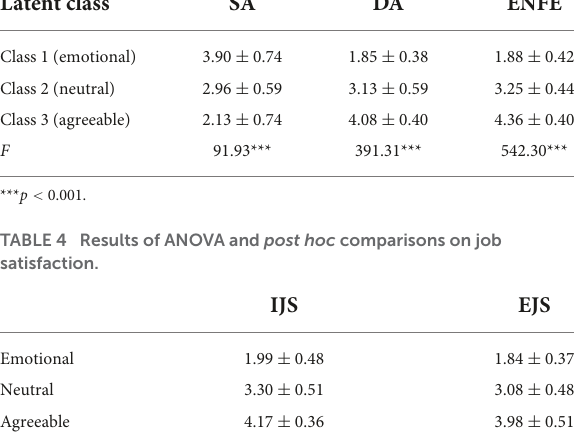
that different profiles of emotional labor can be identified and replicated across cultures (Fouquereau et al., 2018).